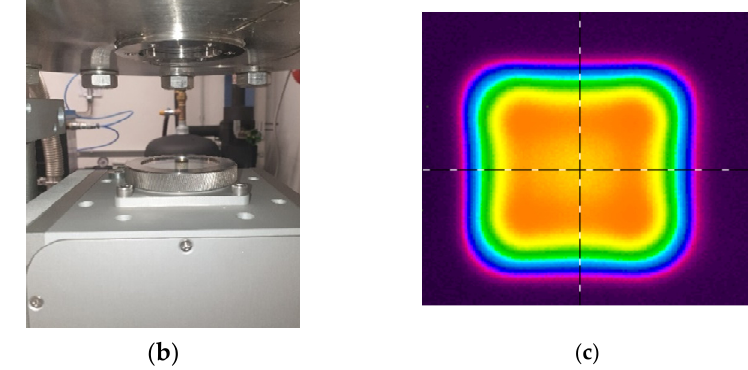
Figure 8 . Laserline LDF 20000-200: ( a ) laser machine; ( b ) Zoom laser optic below the vacuum ves- sel; ( c ) laser spot size 19 × 19 mm 2 . ( c ) laser spot size 19 × 19 mm 2